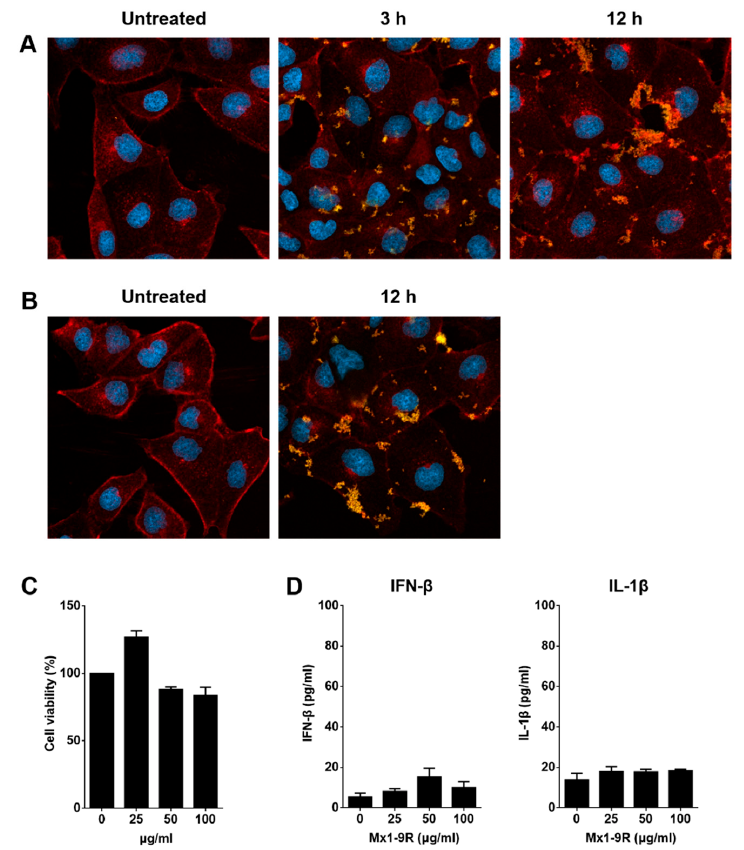
Figure 2. Transduction of Mx1-9R in vitro. Madin-Darby Canine Kidney (MDCK) cells were incubated with ( A ) 50 µ g/mL or ( B ) 25 µ g/mL of Mx1-9R. At 3–12 h after incubation, cells were